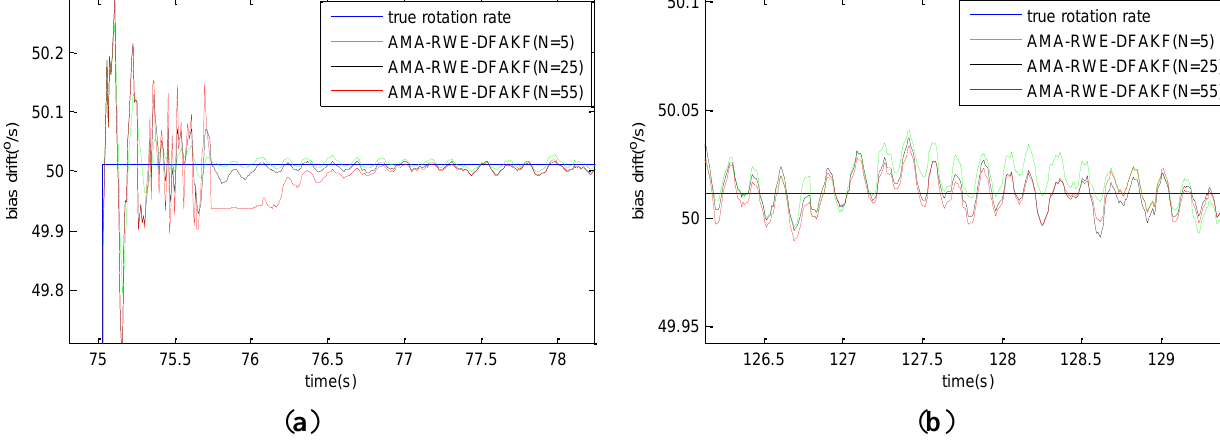
Figure 12. Comparison of denoising results for FOG signal with different parameters. ( a ) Comparison of convergence speeds; ( b ) Comparison of filtering accuracy.